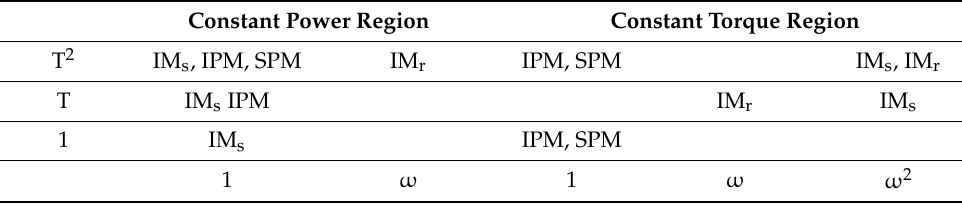
Table 2. The dependency of the machine ohmic losses on the torque and speed of the machine rendering an approximation of the loss in different operating points for each type of the machine